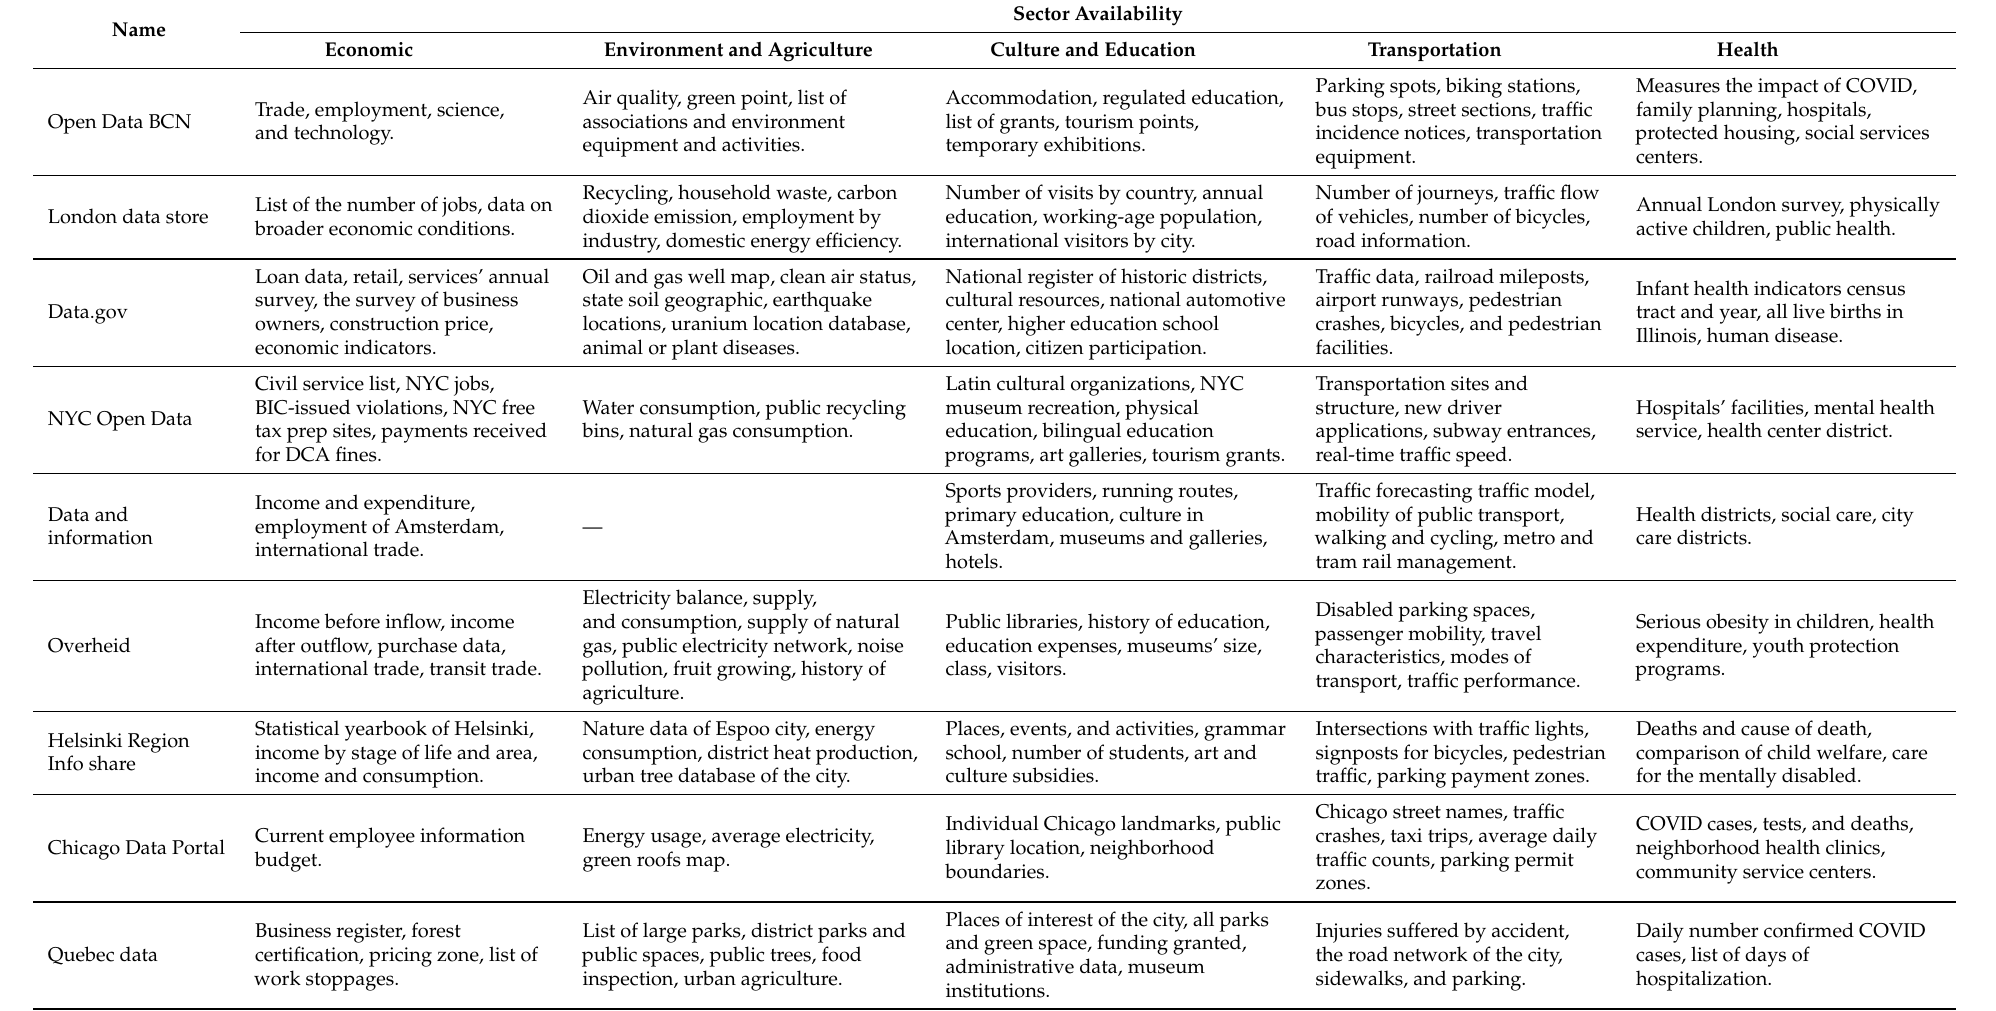
Table 2. Sector availability data set in open data initiatives of smart